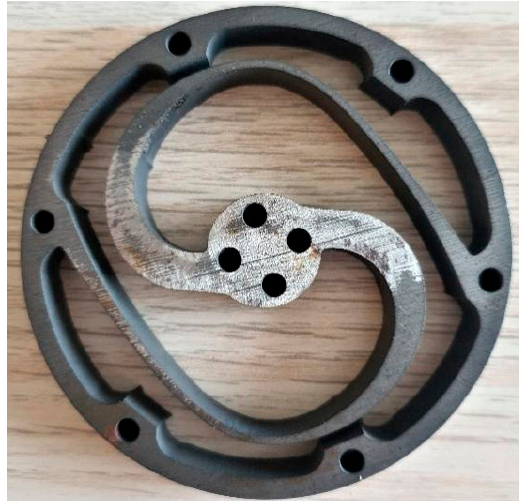
Figure 10. Manufactured torsion spring.